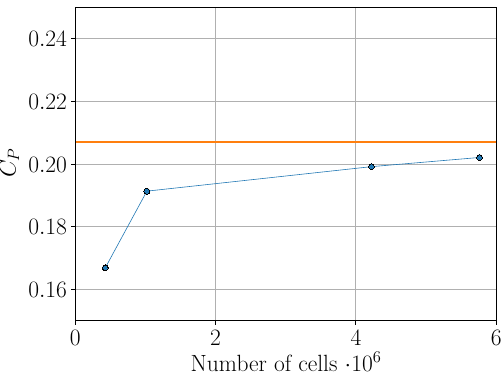
Figure 6. The power coefficient response to a grid size variation for a TSR of λ = 1. The horizontal orange line represents the experimental value for the tested λ